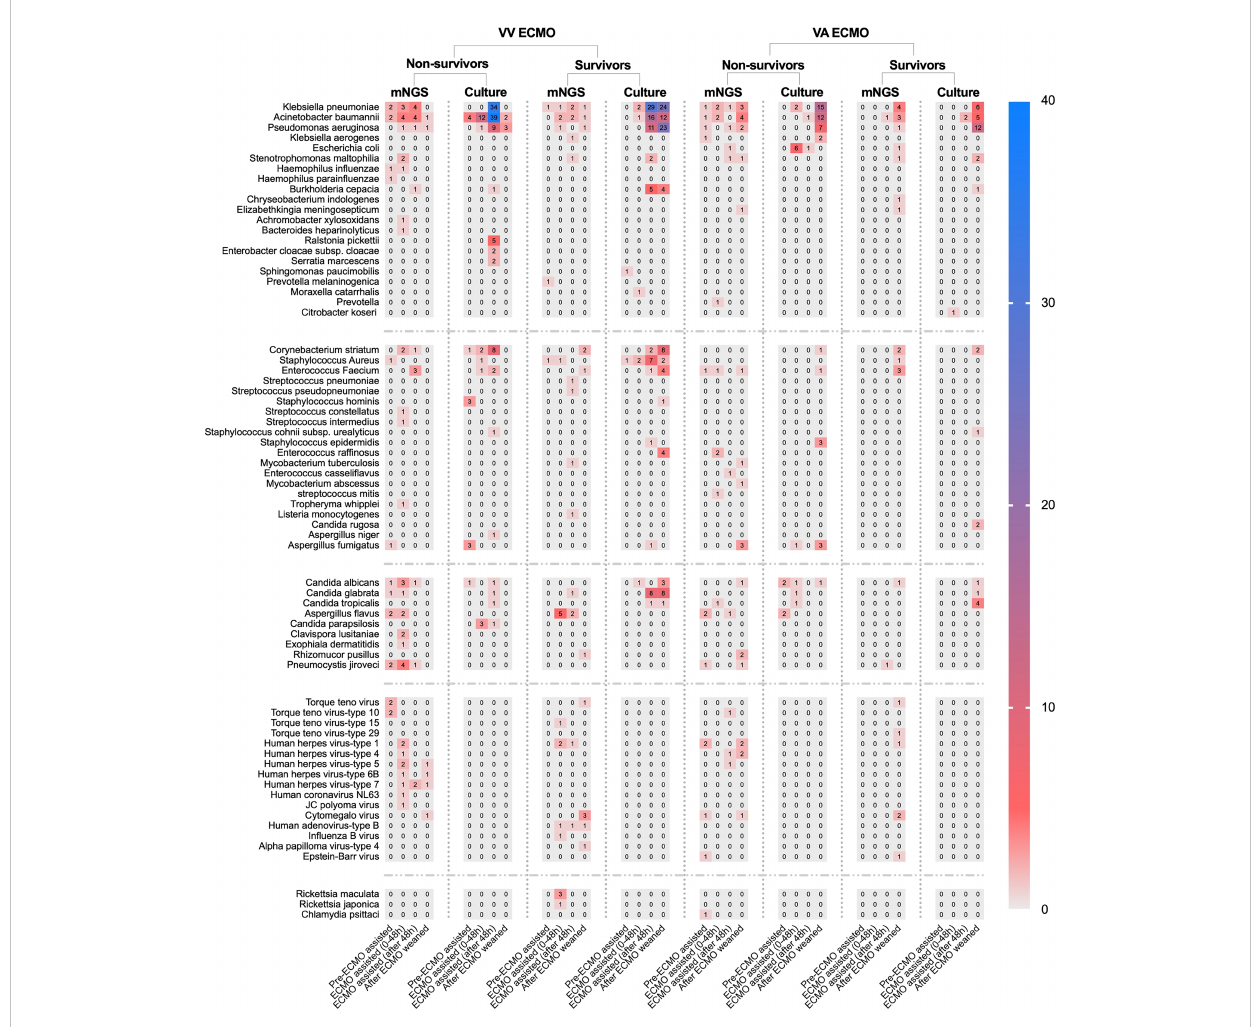
FIGURE 4 The heat map of pathogenic microorganism details in non-survivors and survivors of different ECMO assistance types (VV ECMO and VA ECMO) in different time periods (before ECMO assistance, within 48 h of ECMO assistance, after 48 h of ECMO assistance, and after weaning of ECMO). ECMO, extracorporeal membrane oxygenation; VV, veno-venous; VA,